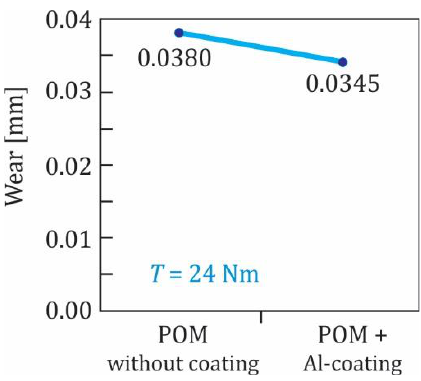
Figure 13. Wear of POM-gears at the torque 24 Nm.